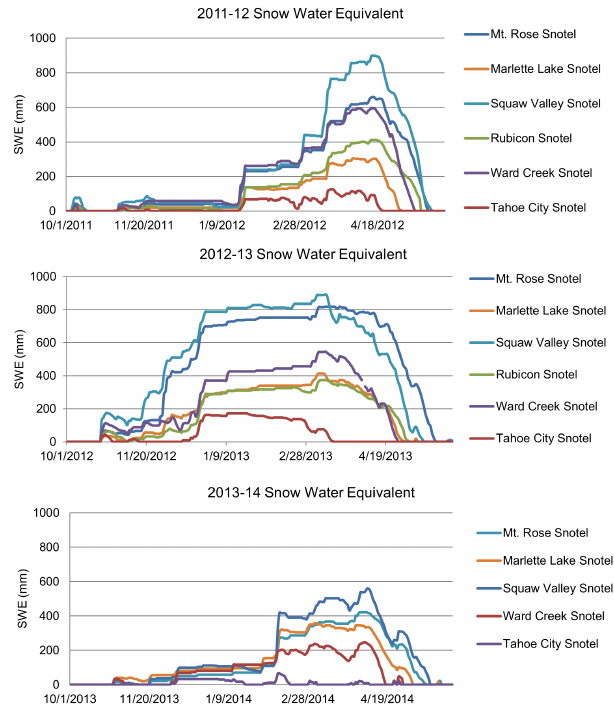
Figure 3. Snow water equivalent measured in 2011–2012, 2012– 2013, and 2013–2014 at select SNOTEL sites (NRCS, 2013) throughout the Lake Tahoe